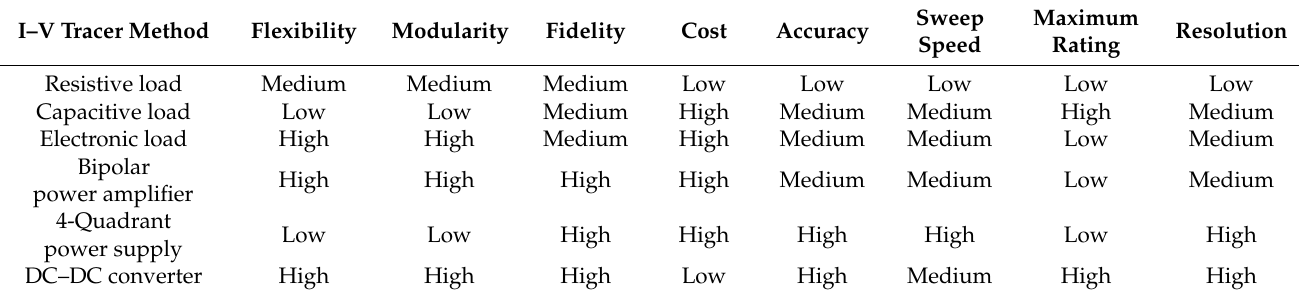
Table 1. Comparison of the advantages and disadvantages of the analyzed I–V tracers’ topologies.